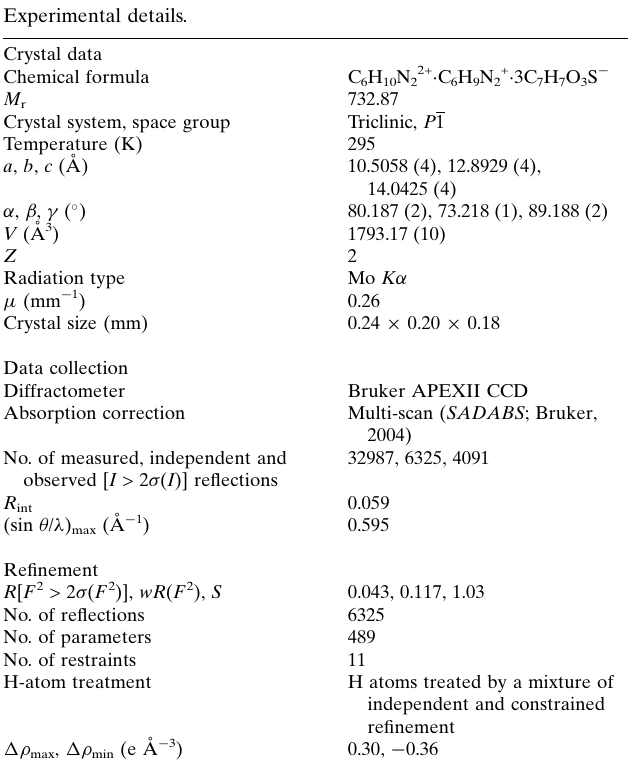
Table 2 Experimental details. Crystal data Chemical